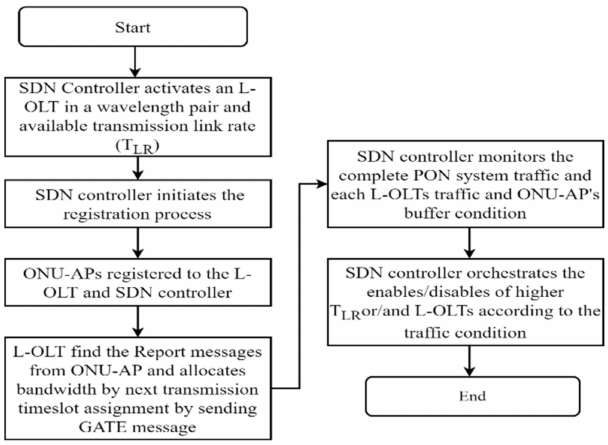
Figure 4. SDN-enabled overall system activation and